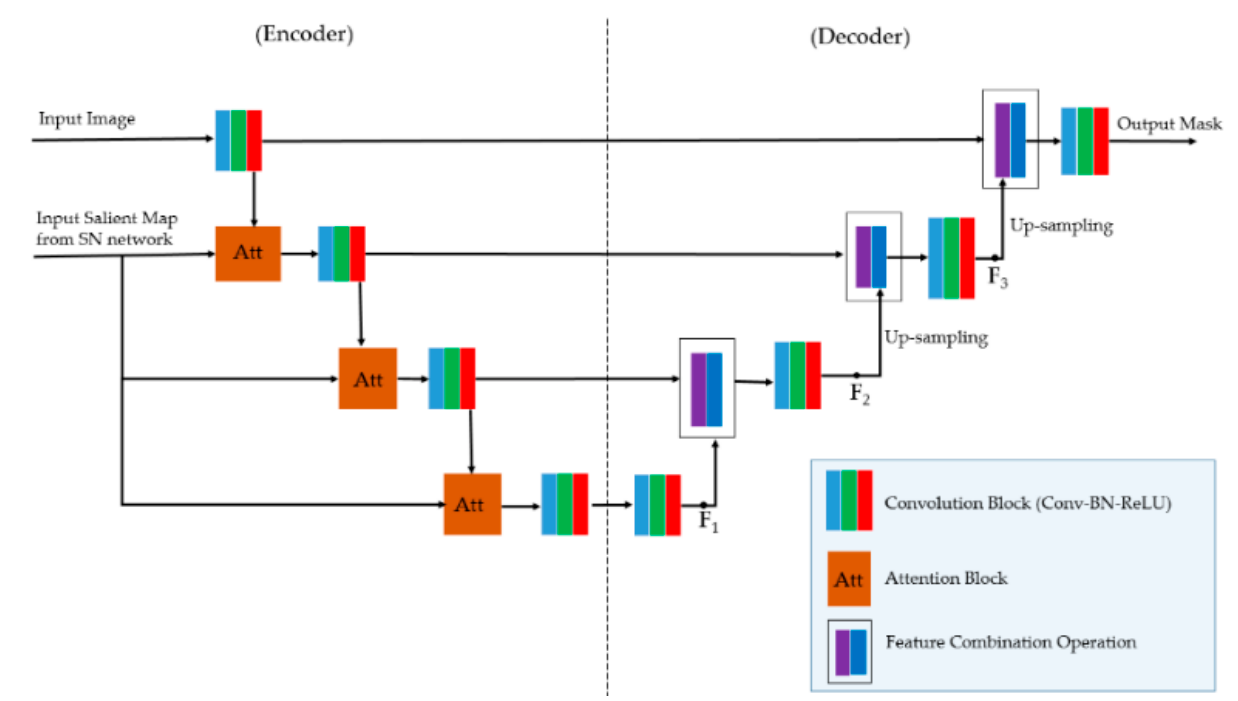
Figure 4. Conceptual diagram of proposed enhancement network (EN).